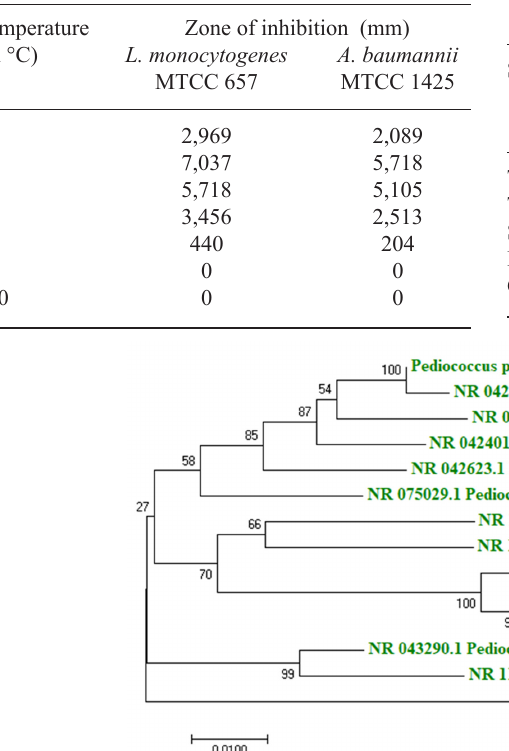
Table 4. Effect of temperature on antimicrobial activity of partially purified bacteriocin